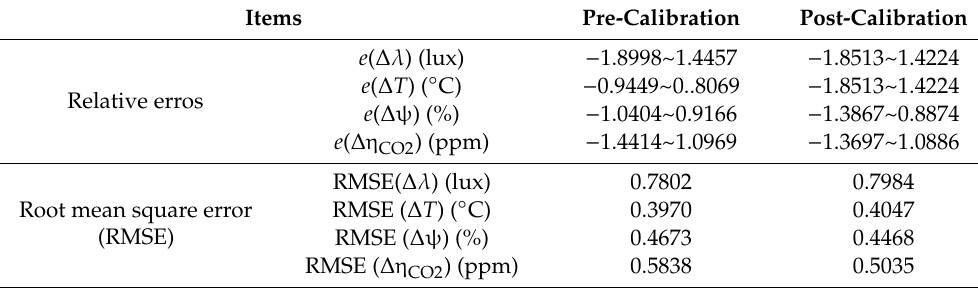
Table 2. Accuracy analysis of the proposed multisensor